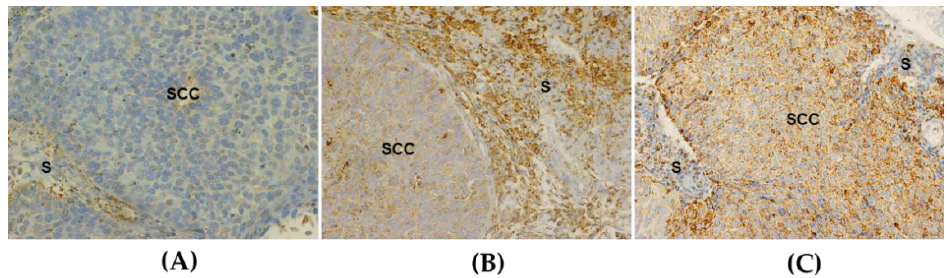
Figure 1. Representative immunohistochemical analysis of SOD2 expression in squamous cell carcinoma of the cervix (200 × ). Granulated-like cytoplasmic expression in negative ( A ), moderate ( B ), and strong ( C ) staining in neoplastic cells. SCC = squamous cervical carcinoma. S = stromal cells.